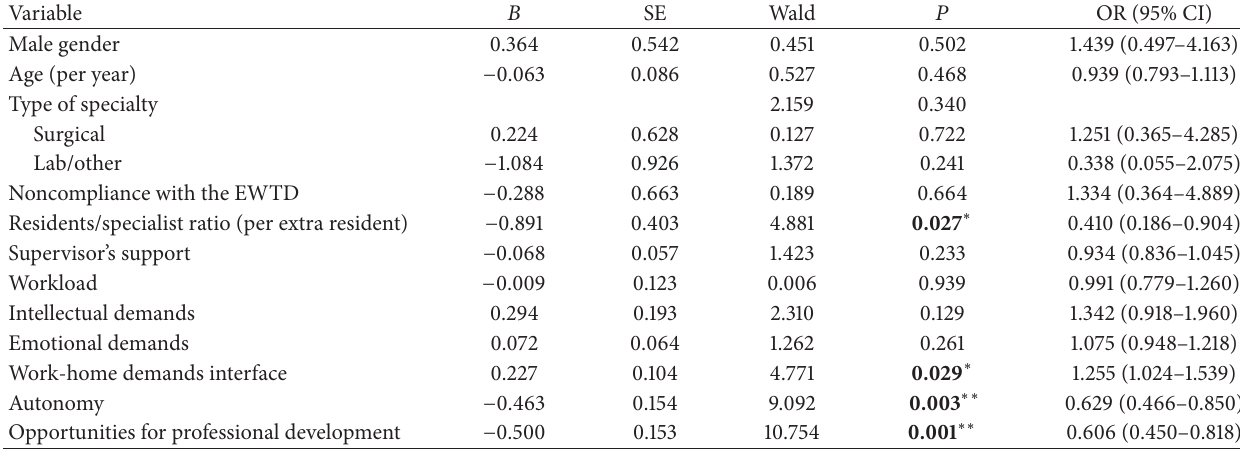
Table 4: Logistic regression of residents’ burnout on demographic and work-related variables, as well as job demands and job